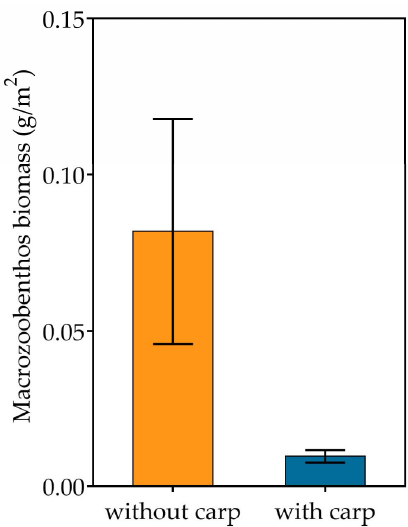
Figure 5. Comparisons of macrozoobenthos biomass between the fish-present and -absent treatments. Values denote mean ± SE ( n = 3).